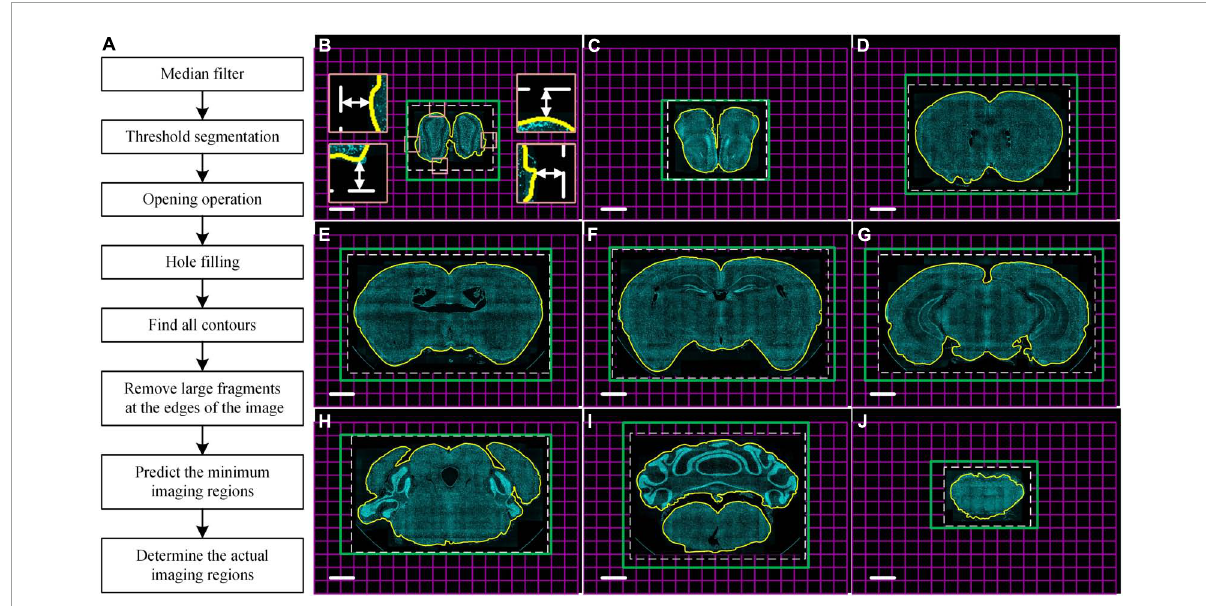
FIGURE3 Real-time automatic contour recognition of the whole-brain imaging. (A) Flow diagram. (B–J) Typical contour recognition results in the whole brain with a 1.25 mm axial interval based on DAPI-staining cytoarchitecture. Yellow curves indicate the identified contour of the brain sample in the raw data. White dotted boxes indicate the minimum imaging regions of the next layer predicted by the real-time automatic contour recognition. Four insets in (B) enlarge the corresponding views of the tangency point of the circumscribed rectangle of the sample indicated by pink squares in (B) . Double-headed arrows in the four insets of (B) indicate a distance of 288 µ m from the tangency point to the defined minimum imaging range. Green boxes indicate the actual imaging regions of the corresponding next layers. Each magenta square indicates single FOV. These images are recorded at the same coordinates to ensure the auto-registration of the whole dataset. Scale bars: (B–J) 1